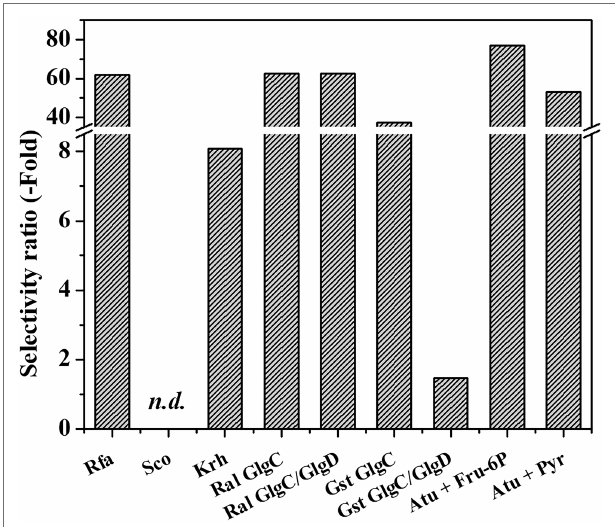
FIGURE 2 | Selectivity ratios for glucose-1-phosphate (Glc-1P) and GlcN- 1P (ratio between catalytic efficiency for the use of Glc-1P over that with